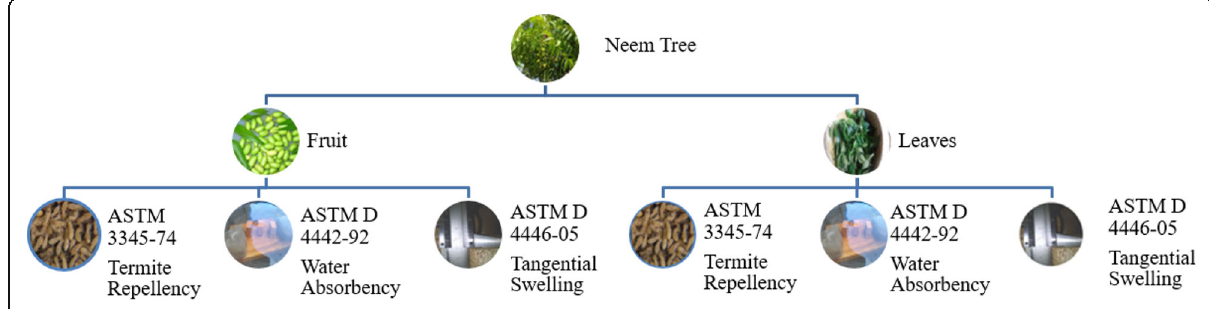
Fig. 4 The experimental processes and property analysis method